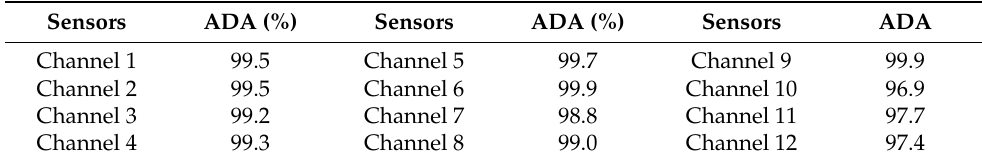
Figure 14. An example of anomaly detection with proposed method.